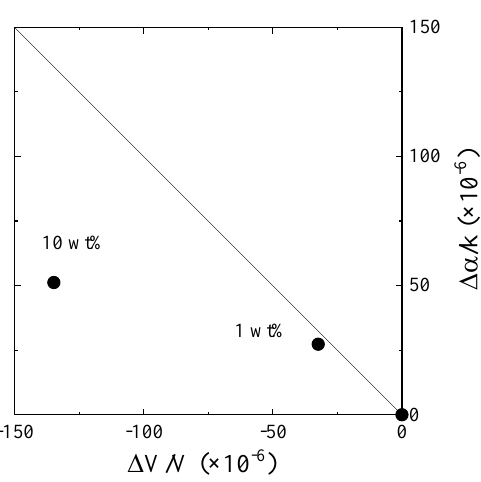
Figure 12. Evaluation of the SH-SAW sensor responses obtained from Ch.1 for the water contained in engine oil. The solid line shows the Newtonian fluid.